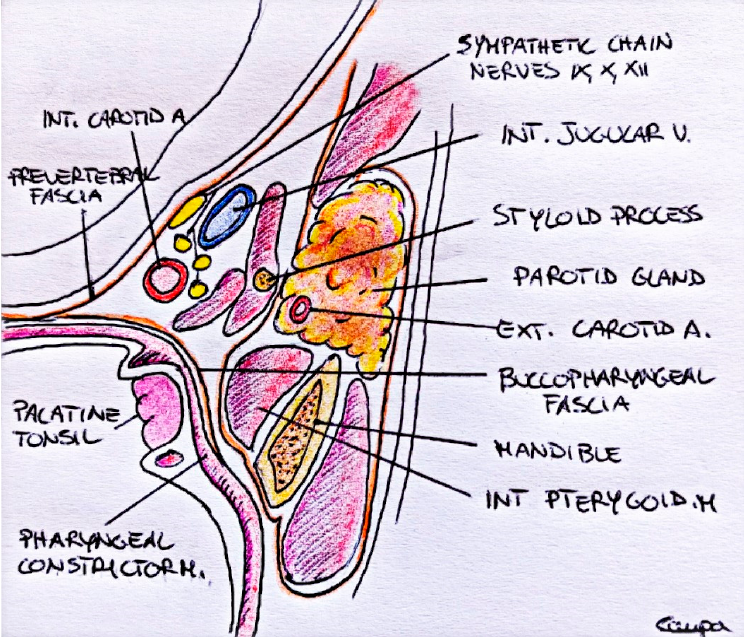
Figure 1. Axial section of parapharyngeal space anatomy showing fascia delimiting this space and main muscular, vascular, and nervous structures crossing PS.